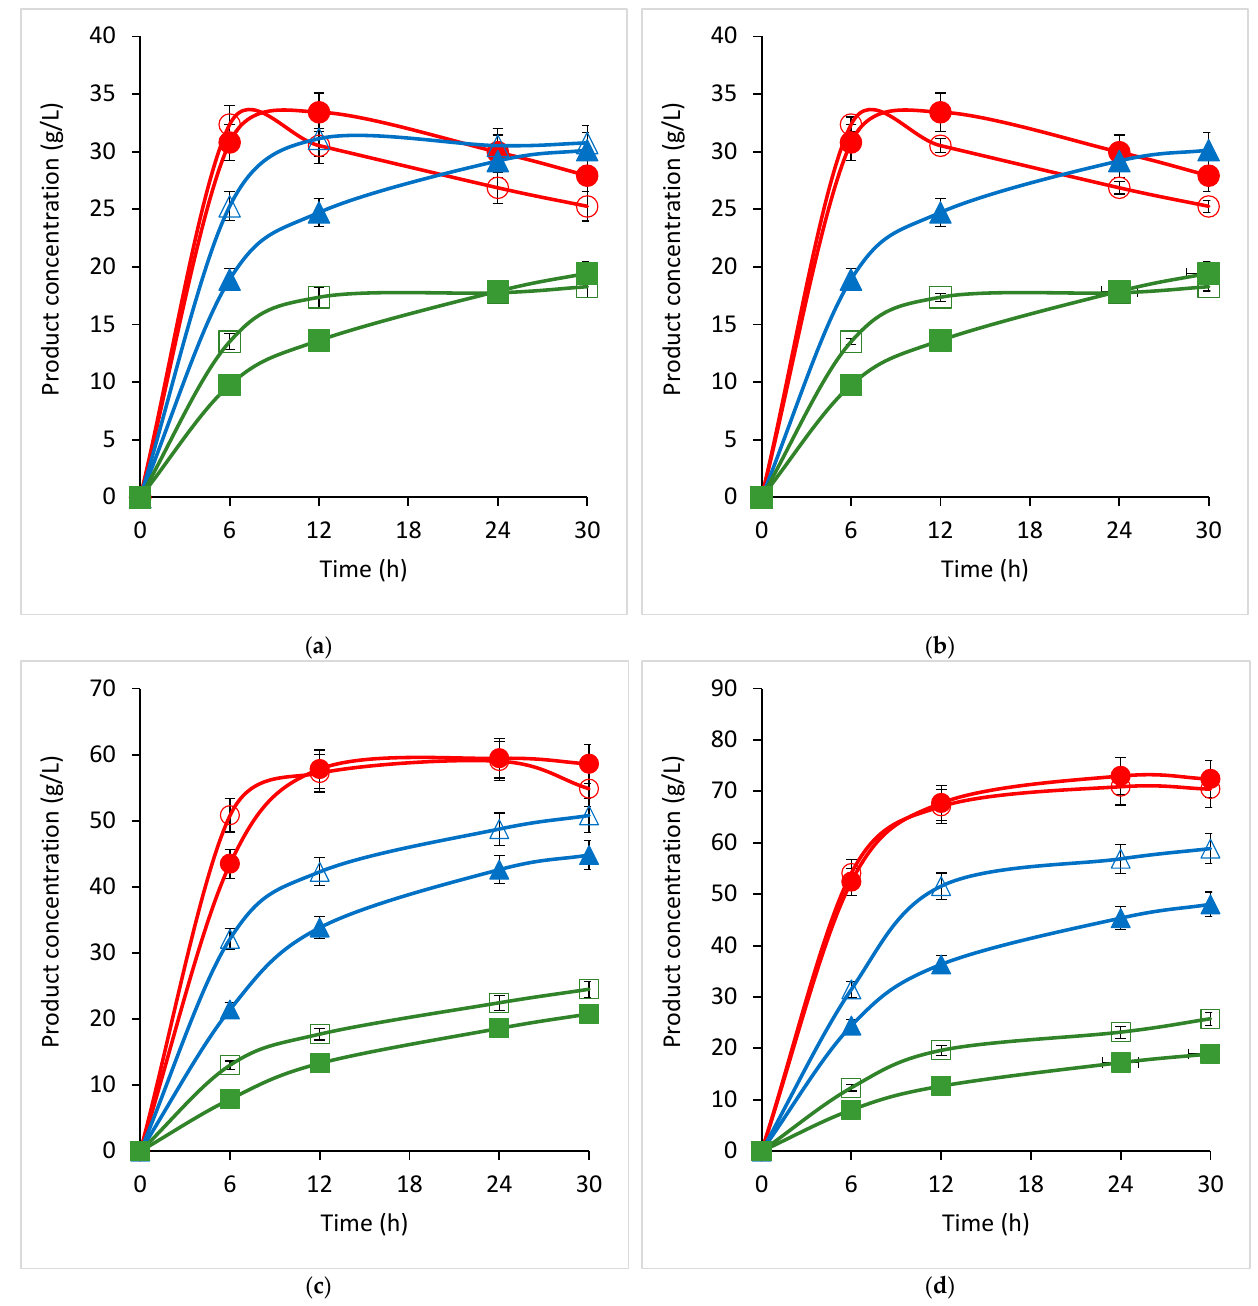
Figure 10. Time profiles of products formation by the action of the recombinant β -galactosidase with different concentrations of lactose: ( a ) 80 g/L; ( b ) 120 g/L; ( c ) 160 g/L; ( d ) 200 g/L of lactose. Legend: red, DP3; blue, glucose; green, galactose. Opened symbols, lactose + 1mM of MgSO 4 ; closed symbols, lactose + 10 mM of MgSO 4 , 10 mM of MnSO 4 , and 10 mM of CaCl 2 . Three independent trials were performed.